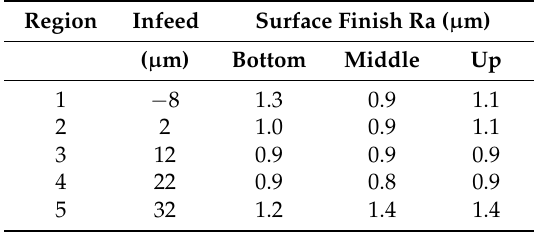
Table 2. Infeed values and surface finish for each region at different heights.